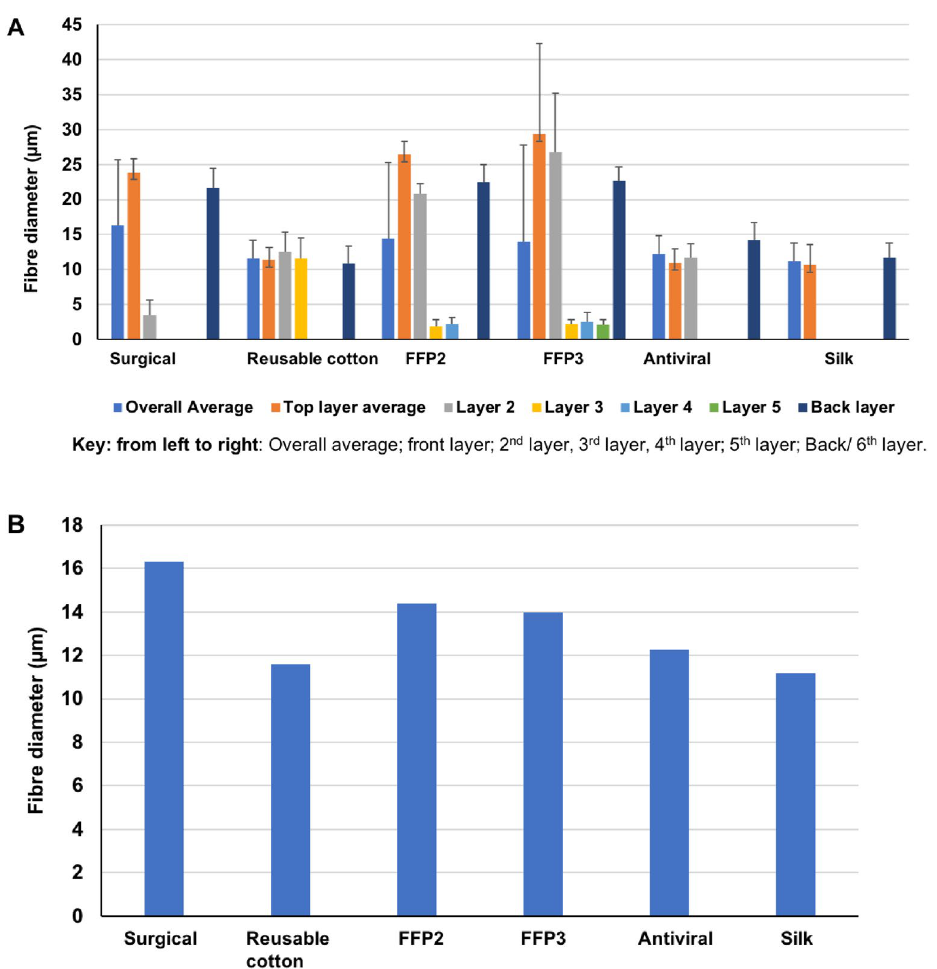
Figure 9. The fibre diameter for the six masks was derived from their individual layer measurements. ( A ) for each layer. ( B ) average fibre diameter of each